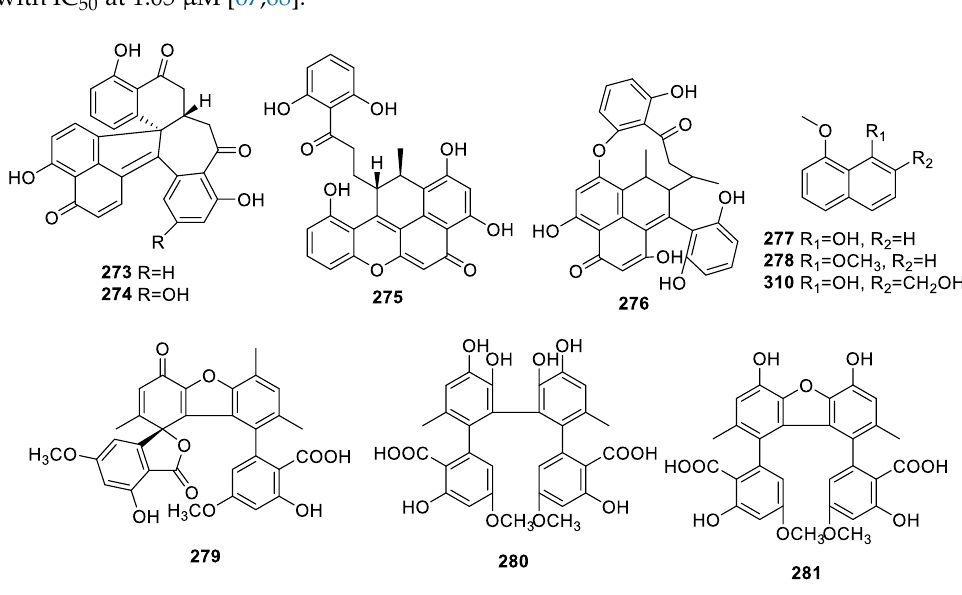
Figure 11. Chemical structures of other polyketides ( 273 – 281 , 310